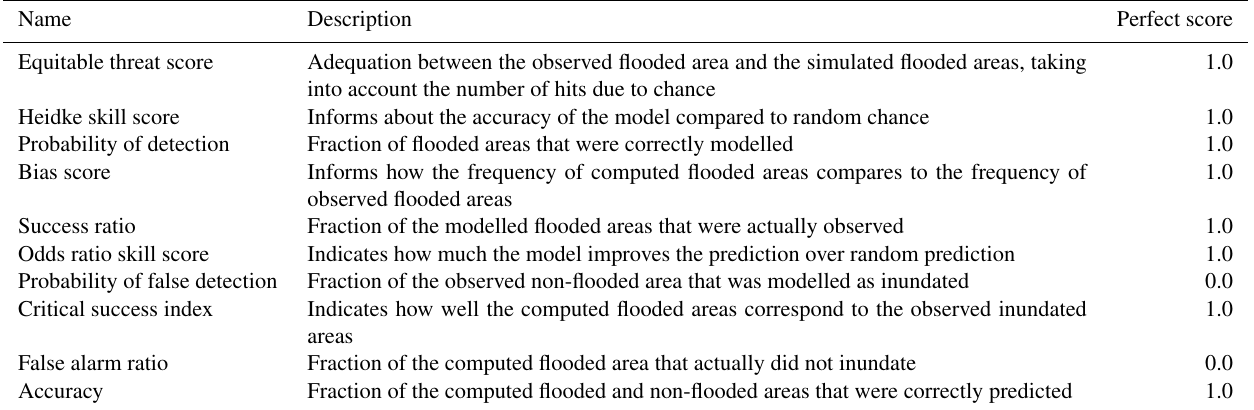
Table 4. Short description of the skill scores used in this paper (Stanski et al., 1989; Brooks et al.,